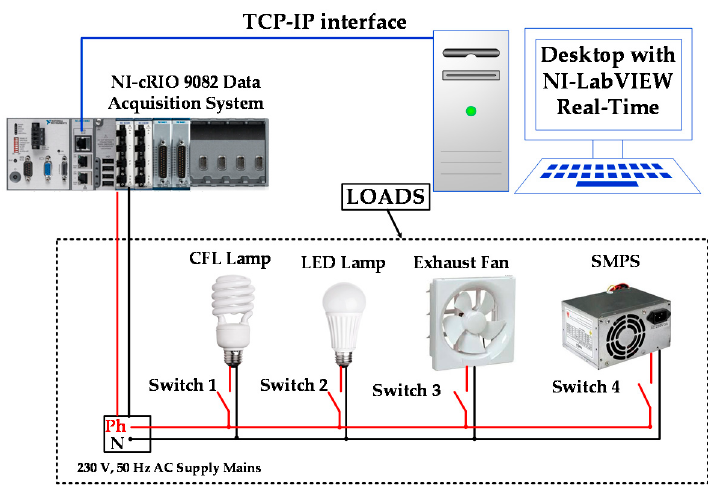
Figure 3. Hardware schematic for percentage THD computation.